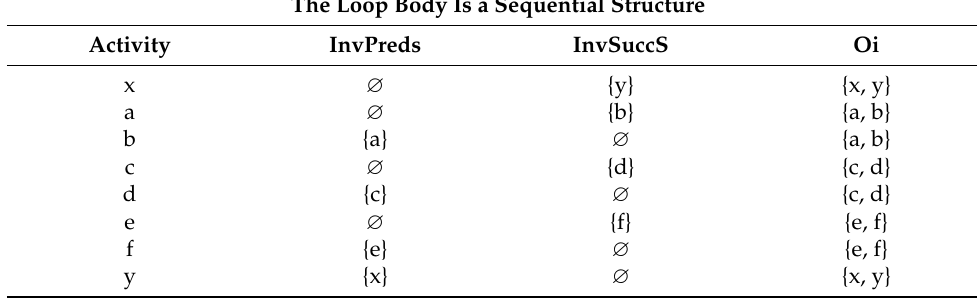
Table 9. Invariant set of activities in Figure